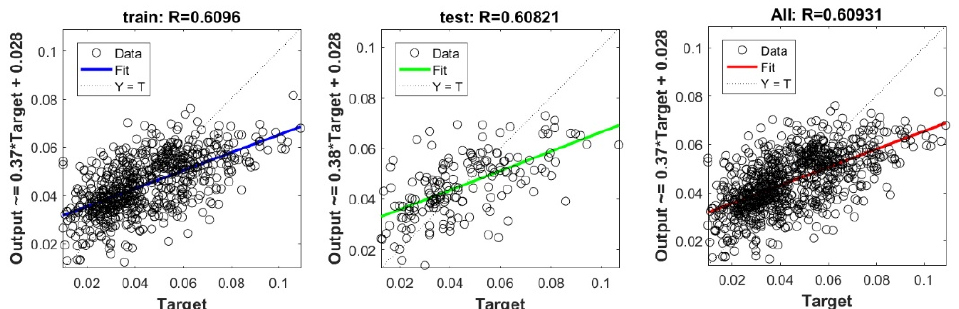
Figure A7. Scatter plots between target and output value by the FS-PLS model.